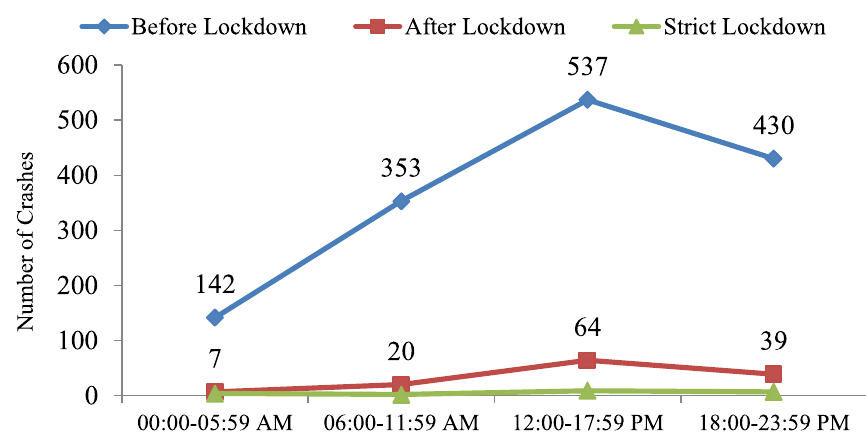
Fig. 9 Time-wise analysis of crash data